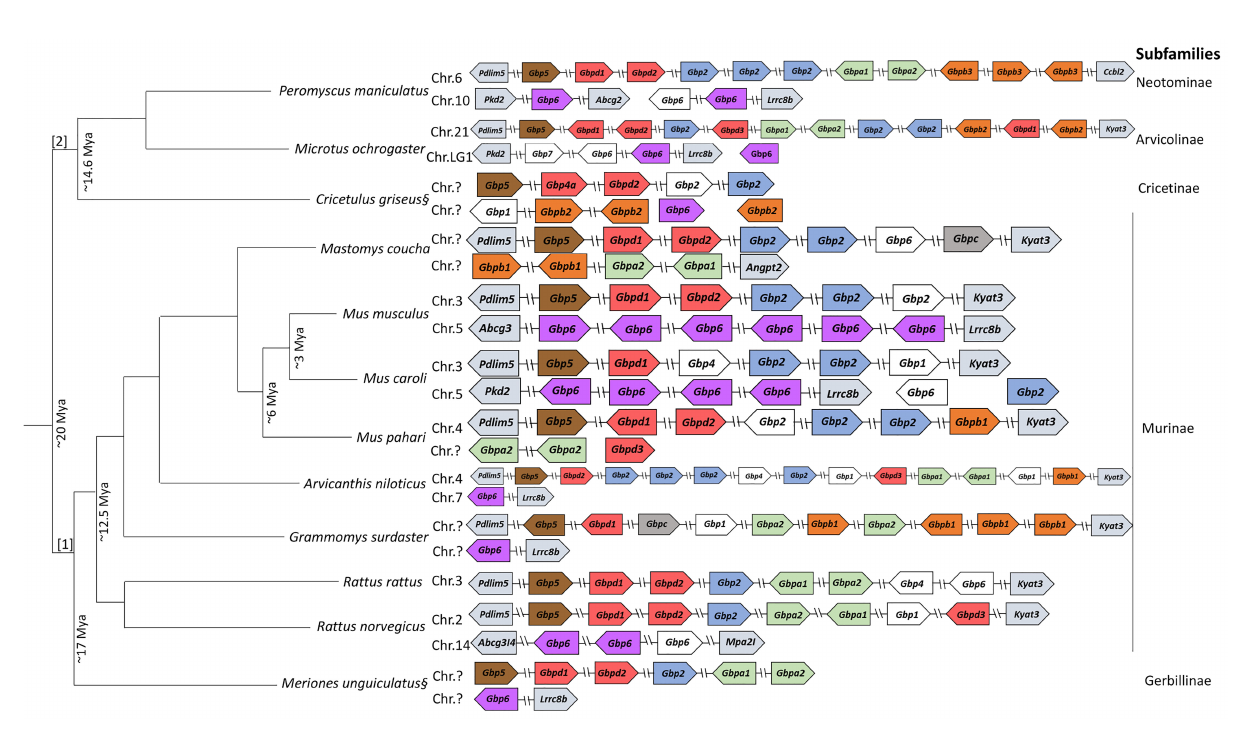
FIGURE 2 | Gbp gene family synteny in Muridae and Cricetidae. Organization of the Gbp gene family in the species studied according to genomes available in NCBI (www.ncbi.nlm.nih.org) and Ensembl (wwww.ensembl.org). Arrows represent transcription orientation. White boxes indicate pseudogenes. The diagram is not to drawn to scale. Chromosomes are indicated when information is available. § Putative representation of the Gbp gene family in Cricetulus griseus and Meriones unguiculatus . [1]: Muridae; [2]: Cricetidae. Color